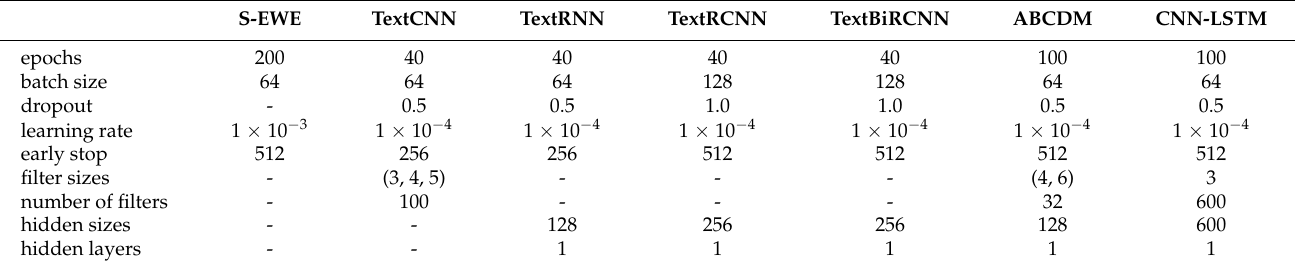
Table 4. Parameter details of different